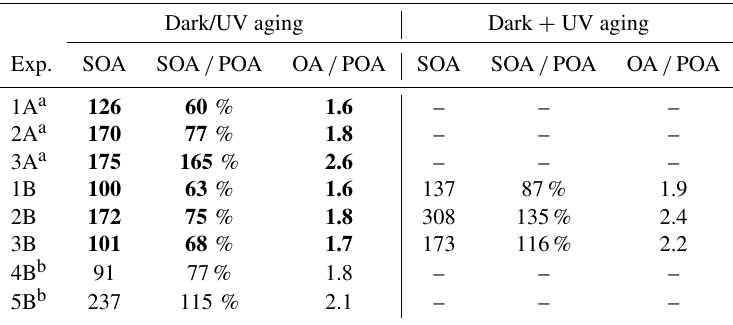
Table 3. SOA (OA-POA) emissions (mgkg − 1 fuel) and SOA-to-POA / OA-to-POA ratios for all of the experiments. Dark aging results are shown in bold.